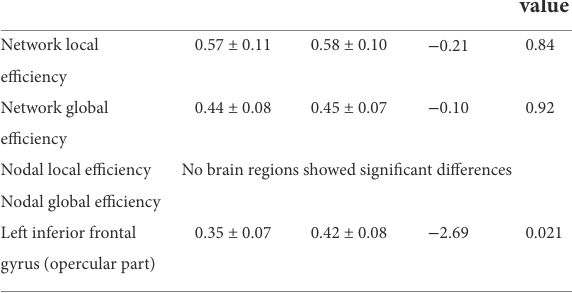
TABLE 3 Comparison of AUC of network and nodal efficiency of male rowing athletes before and after tDCS.